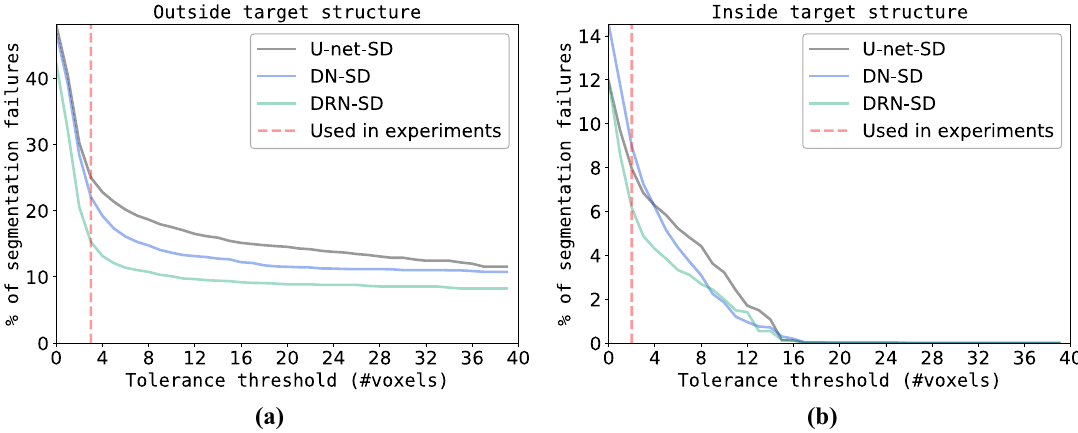
Figure 8. Mean percentage of the segmentation failures per volume (y-axis) in the set of all segmentation errors (tolerable errors + segmentation failures) depending on the tolerance threshold (x-axis). Red, dashed vertical line indicates threshold value that was used throughout the experiments. Results are split between segmentation errors located (a) outside and (b) inside the target structure. Each figure contains a curve for U-net, Dilated Network (DN) and Dilated Residual Network (DRN) trained with the soft-Dice (SD) loss. Segmentation errors located in slices above the base or below the apex are always included in the set of segmentation failures and therefore, they are independent of the applied tolerance